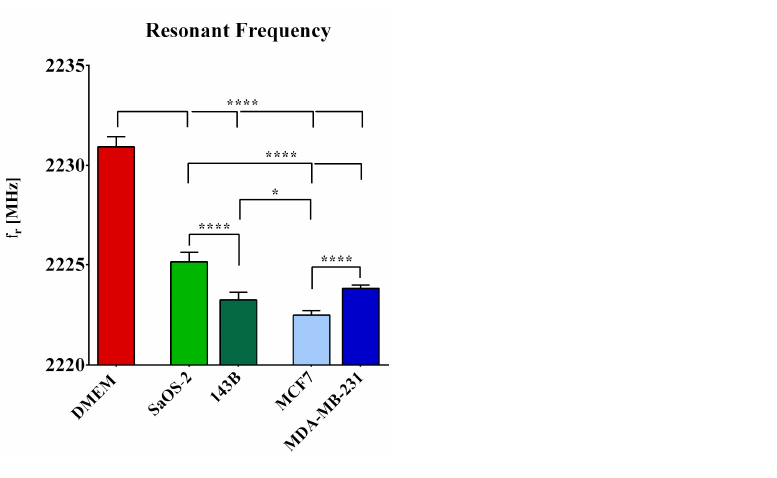
Figure 4. Resonant frequency values computed for pure DMEM, and the four tested cell lines: low-aggressive SaOS-2 and high-aggressive 143B osteosarcoma cell lines, and low-aggressive MCF7 and high-aggressive MDA-MB-231 breast cancer cell lines. n = 8. *, p < 0.05 and ****, p < 0.0001. With regard to the difference in aggressiveness within tumors from the same tissue of origin, post hoc tests revealed a highly significant ( p < 0.0001) difference between SaOS- 2 and 143B cell lines and between MCF-7 and MDA-MB-231 cell lines, showing the poten- tial ability of the sensor to discriminate cell aggressiveness. Interestingly, this was ob- tained even if the increase in aggressiveness was associated with a different behavior in the two cancer cell types. In particular, high-aggressive 143B osteosarcoma cells showed a decrease in the resonant frequency, while high-aggressive breast cancer cells showed an increase in f r . This outcome highlighted the high sensitivity of the biosensor in terms of frequency. Finally, post hoc tests showed statistically significant differences in the frequency value of high-aggressive cells as compared with low-aggressive cells, even for cells from different tumor types, namely 143B osteosarcoma cells versus MCF7 breast cells and MDA-MB-231 breast cells versus SaOS-2 osteosarcoma cells. Figure 5 shows the min|S 11 (f)| and FWHM values for all the tested groups. The re- sults also reflect the fact that these two parameters were affected by a higher measure- ment variance than that reported for the resonant frequency. Figure 5. Min|S 11 (f)| ( a ) and FWHM ( b ) computed for pure DMEM, and the four tested cell lines: low-aggressive SaOS-2 and high-aggressive 143B osteosarcoma cell lines, and low-aggressive MCF7 and high-aggressive MDA-MB-231 breast cancer cell lines. n = 8.